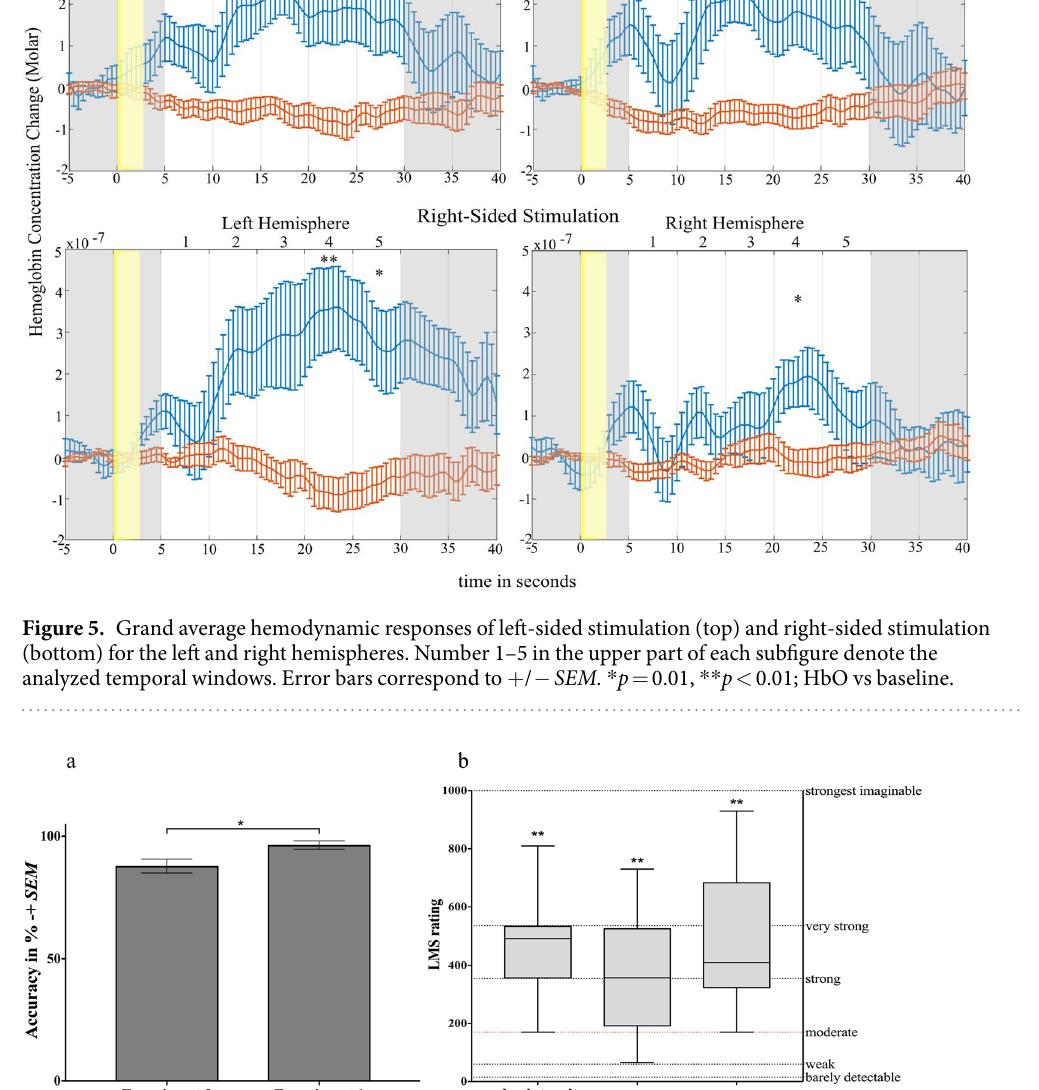
Temporal Differences: Bi- vs. Monorhinal Stimulation.